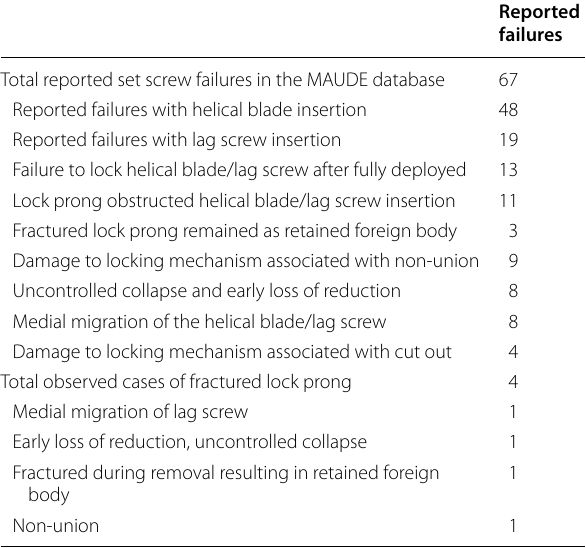
Table 1 Reported failures of the set/screw locking mechanism of TFNa in the FDA’s MAUDE database from 2015 to 2019, and the mechanism of failure in the observed cases of set screw fracture